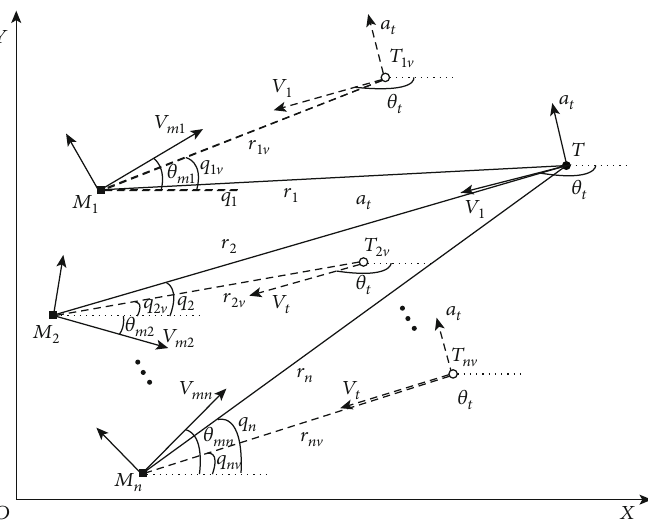
Figure 1: Guidance geometry on Missiles-Target (virtual targets)